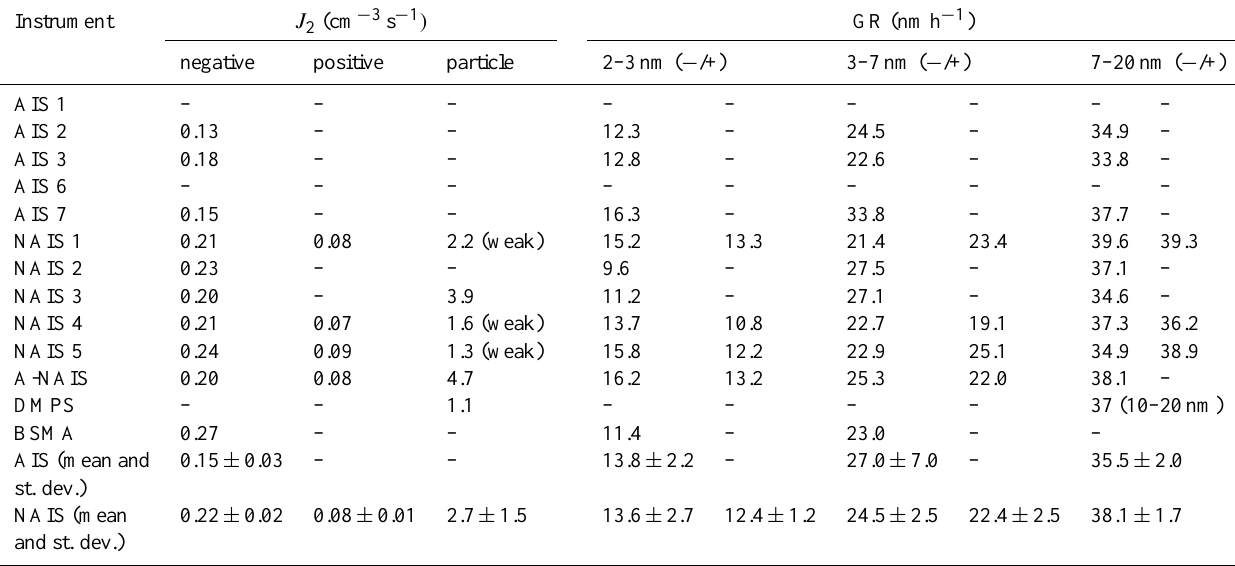
Table 2. Analysis of the 2nd new particle formation event of 12 June 2009 (18:50) by different instruments and ions spectrometers (see Fig. 8 for details). J 2 is the formation rate at 2nm for negative and positive ions, and for total particles. GR is the growth rate of particles negative or positive ( − /+) in different size ranges: 2–3, 3–7 and 7–20nm. The mean and standard deviation for the AISs and NAISs are shown in the last two rows.